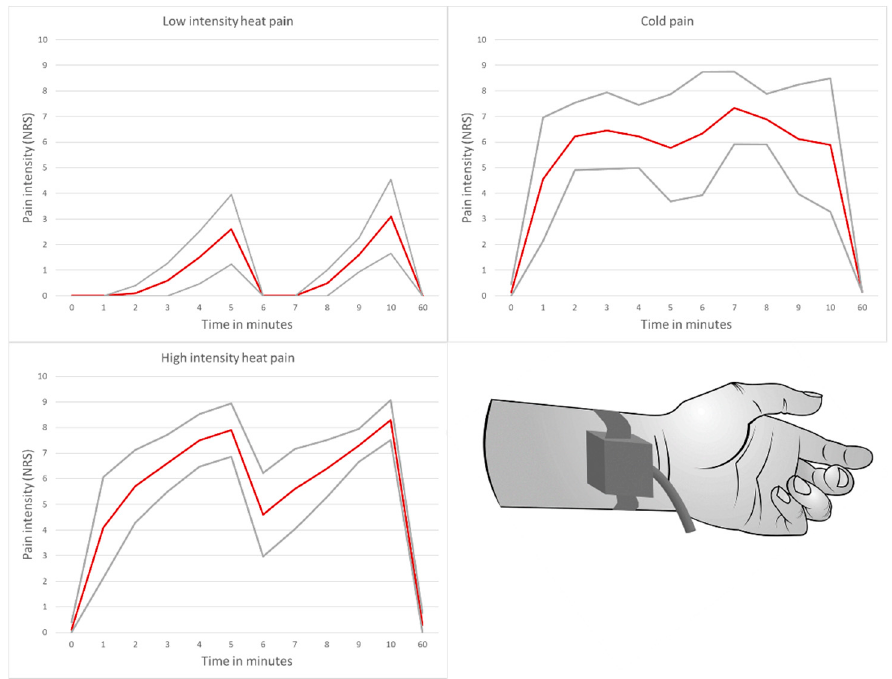
Figure 1. Average pain intensity induced by three different pain models developed by our research group. Thermal nociceptive stimuli were applied by a device for quantitative sensory testing [25]. The red line represents the average perceived pain intensity, the gray lines show the standard deviation.